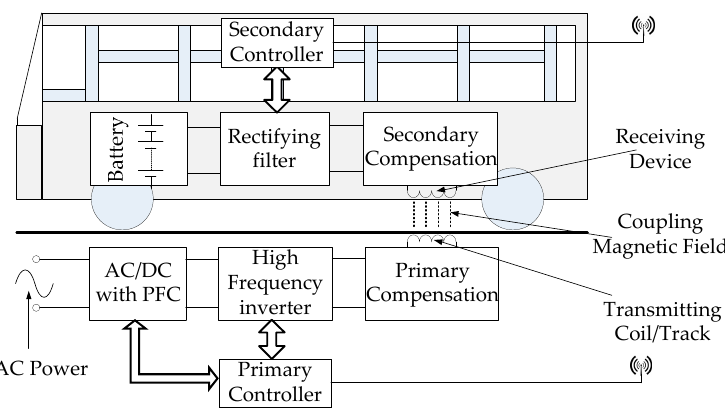
Figure 1. Configuration of the basic structure of wireless-charging system for electric bus.